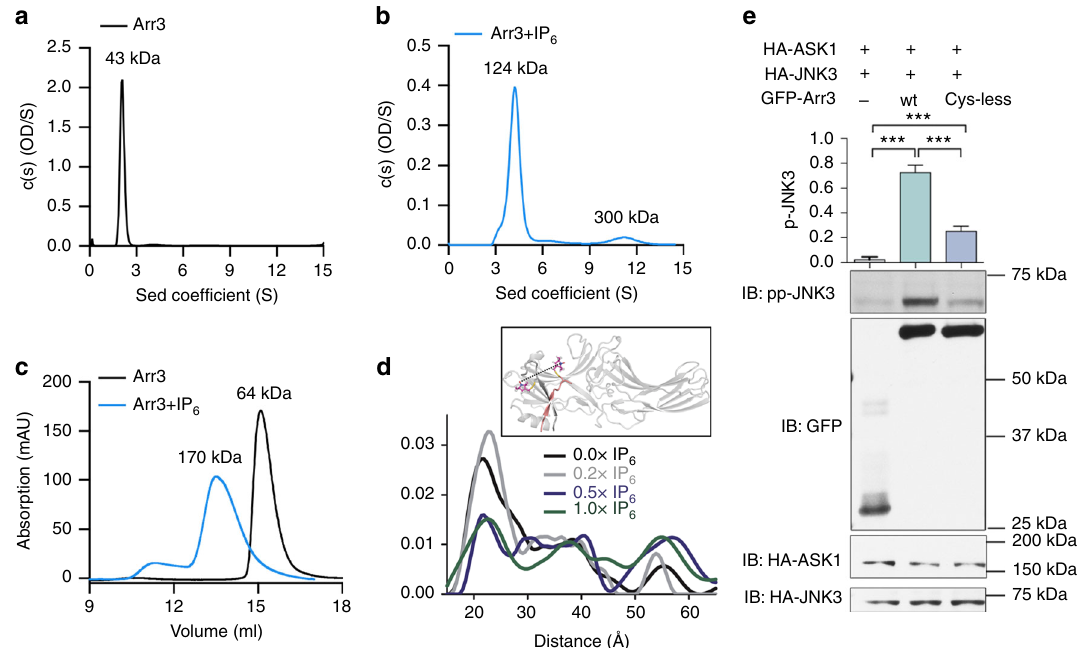
Fig. 3 IP 6 mediated trimerization and receptor-independent activation in cells. a - b Sedimentation velocity analytical ultracentrifugation (SVAUC) of arrestin-3. Measurements were performed in triplicate. a Representative SVAUC run in the absence of IP 6 predicts a molecular weight matching a monomer. b In the presence of 100 µ M IP 6 , the predicted molecular weight is consistent with a trimer. c Representative size exclusion chromatograms of arrestin-3 (Arr3) in the presence and absence of IP 6 . In the absence of IP 6 , 60 µ M arrestin-3 (black) elutes at volume corresponding to the Stokes radius of a globular protein with a molecular mass of 64 ± 5.9 kDa. In the presence of 100 μ M IP 6 , the elution volume is consistent with a globular protein of molecular mass 169.6 ± 9.7 kDa. The ratio of these molecular weights is consistent with IP 6 -dependent trimer formation. Measurements were performed in triplicate, errors are ± SEM. d Plot of the probability of the distances between spin labels at S13 and A392 for 100 µ M arrestin-3 in the presence of the indicated molar ratios of IP 6 ; inset shows the location of the spin labeled sites in basal arrestin-3 (PDB entry 3P2D 6 ). e Comparison of JNK3 activation by GFP-arrestin-3 and Cys-less mutant. GFP-tagged arrestin allowed comparison of the expression levels of wild-type and variant arrestin-3, as described 14,33 . JNK3 activation (mean ± SEM) was assessed by measuring the pp-JNK3 levels in COS7 cells co-transfected with HA-ASK1, HA-JNK3 and GFP or Venus- tagged wild-type and Cys-less arrestin-3. Assay was repeated fi ve times and JNK3 phosphorylation was compared by one-way ANOVA followed by Bonferroni post hoc test with correction for multiple comparisons. *** p <